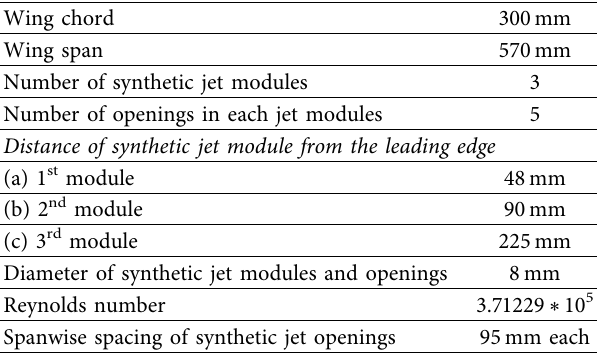
Table 1: Specifications of wing and synthetic jet modules.